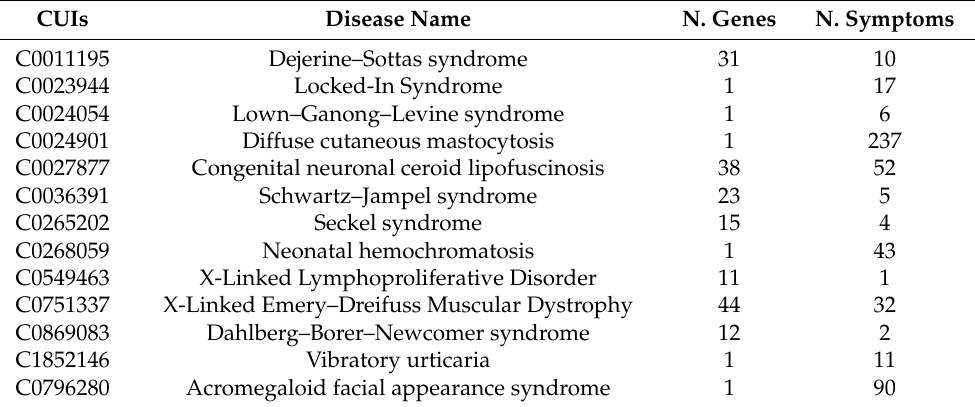
Table 1. Number of genes and symptoms of the 13 rare diseases listed.